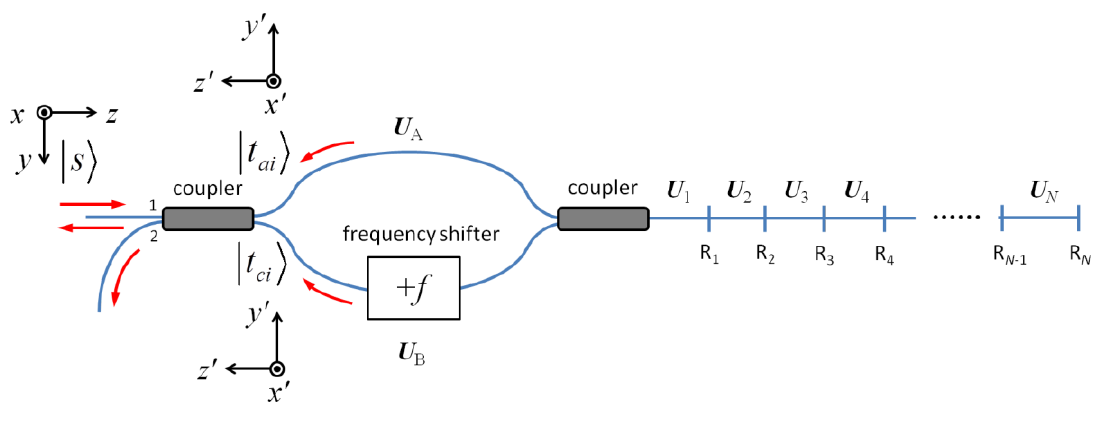
Figure 14. Input and output polarization of a linear frequency-shifted Sagnac interferometer. The coordinate system for the input polarization state s is x - y - z , and that for the output polarization states system x  - y  - z 